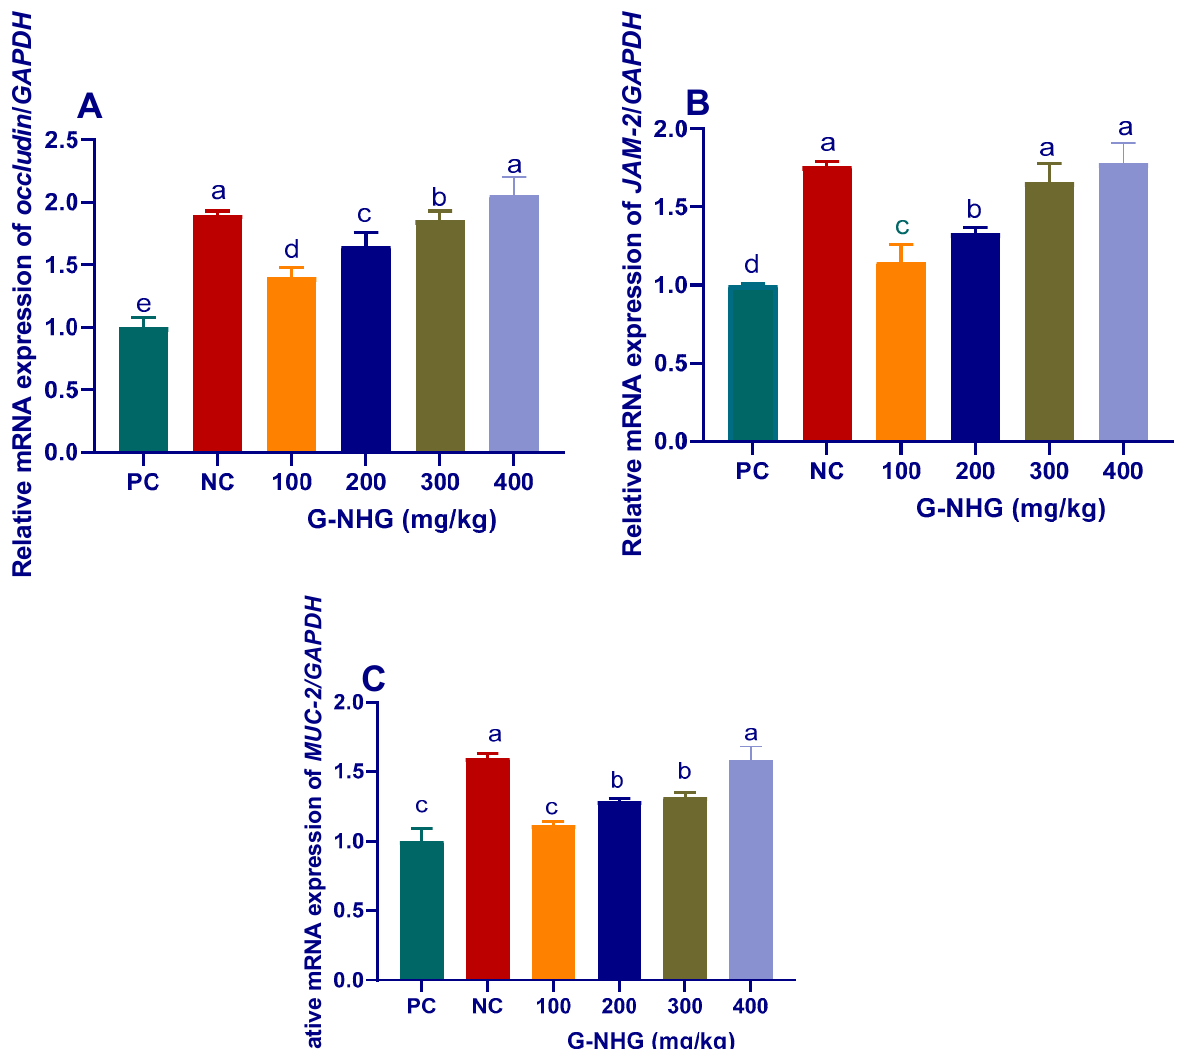
Figure 3. Transcript levels of occludin ( A ), junction adhesion molecules-2 ( JAM-2 , B ) and mucin-2 ( Muc-2 , C ) genes in the duodenal mucosal samples of broiler chickens fed different levels of G-NHG and challenged with C. perfringens on d 21, 22 and 23 of the experiment as measured by RT-qPCR assay. Values are means with their SE in bars. PC (positive control): birds fed a basal diet and challenged with C. perfringens, NC (negative control): birds fed a basal diet, G-NHG (100, 200, 300 or 400 mg/kg)-treated groups: birds fed a basal diet supplemented with 100, 200, 300 or 400 mg/kg of garlic nanohydrogel and challenged with C. perfringens . a–e Means within the same column carrying different superscripts are significantly different at p < 0.05.